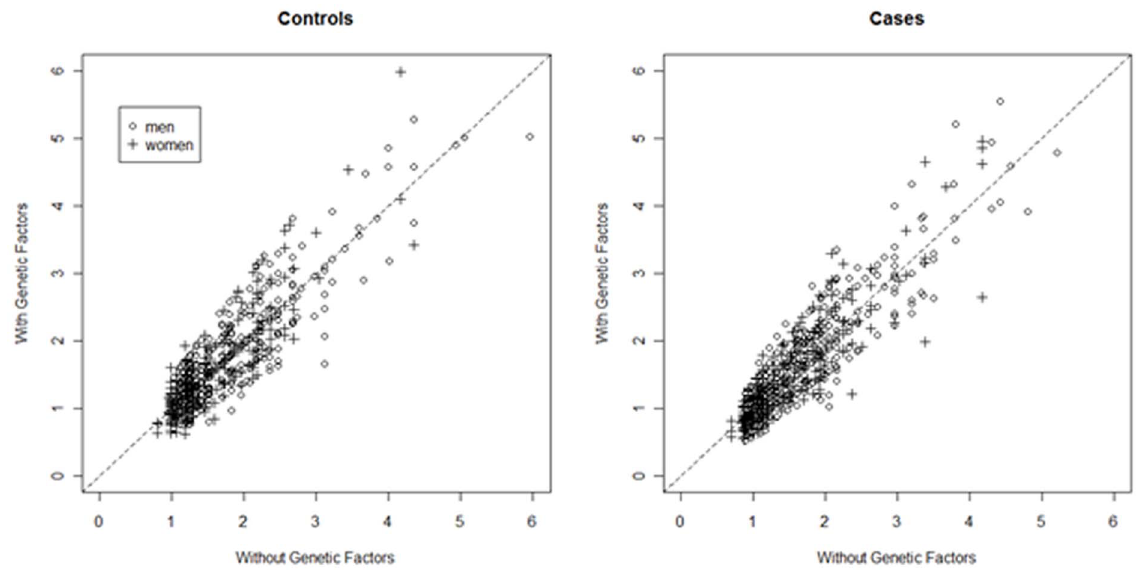
Figure 2. Reclassification of lifetime risk of pancreatic cancer among cohort controls after adding genetic information to the risk model.